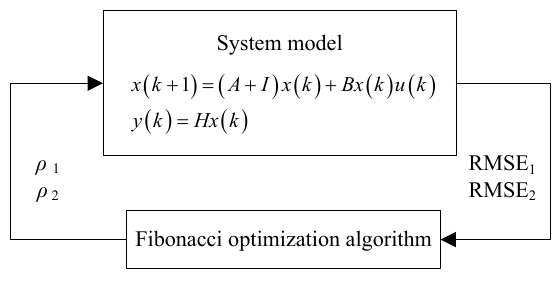
Figure 4. The relationship between the RMSE and ρ .